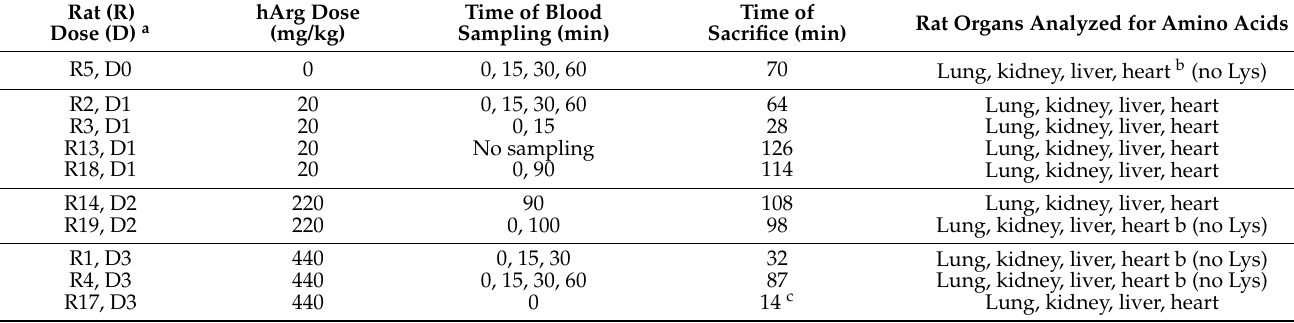
Table 1. Summary of the rats used in the study, the hArg doses applied, the time points of blood sampling and sacrifice, and the organs analyzed for amino